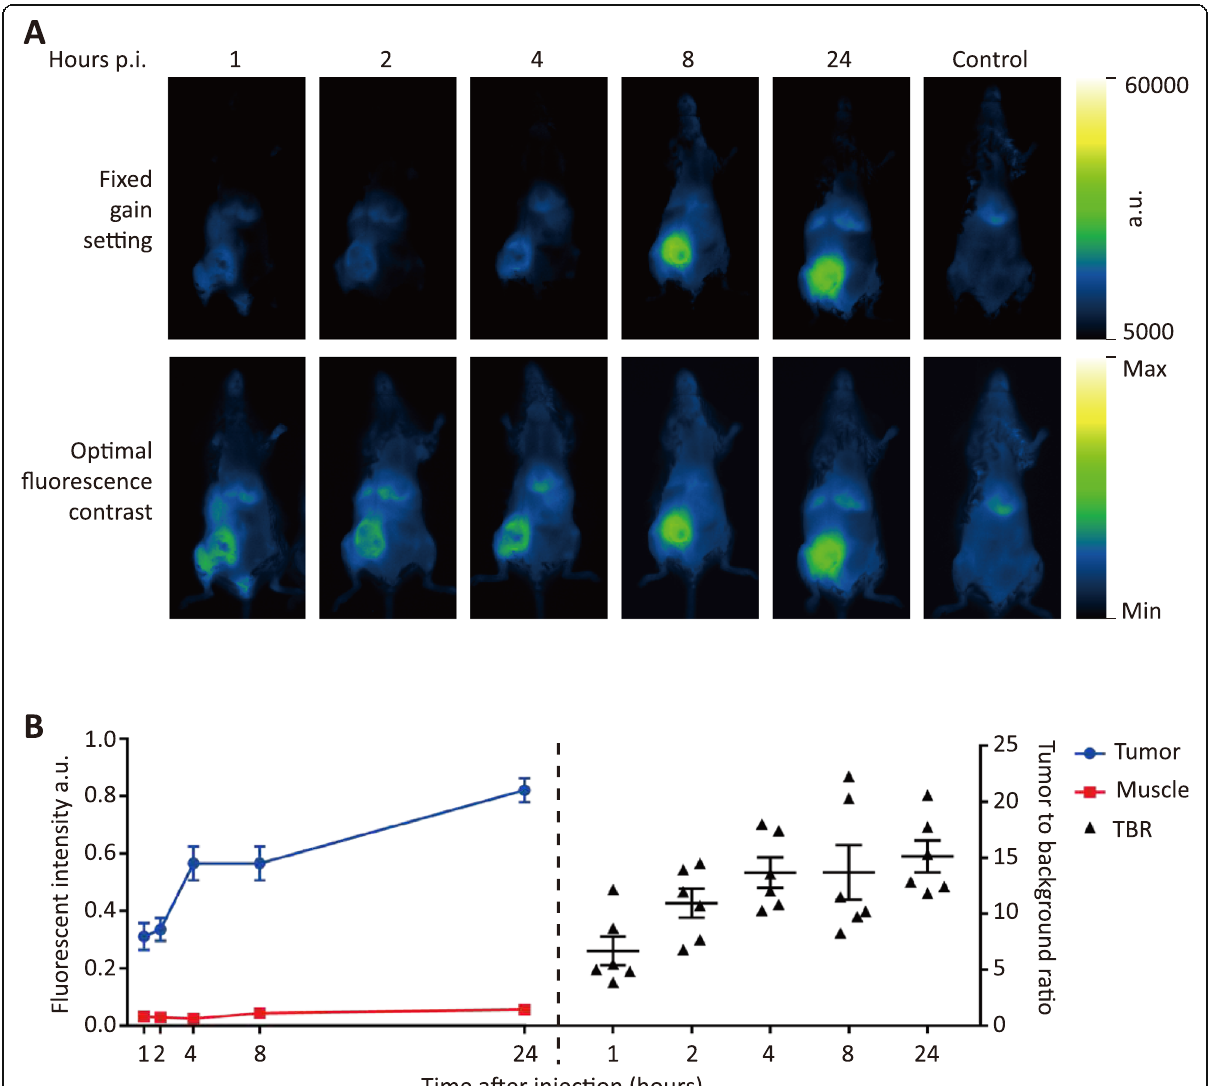
(Supplementary Fig. S3A). For muscle tissue, no F4/80 positive staining was found